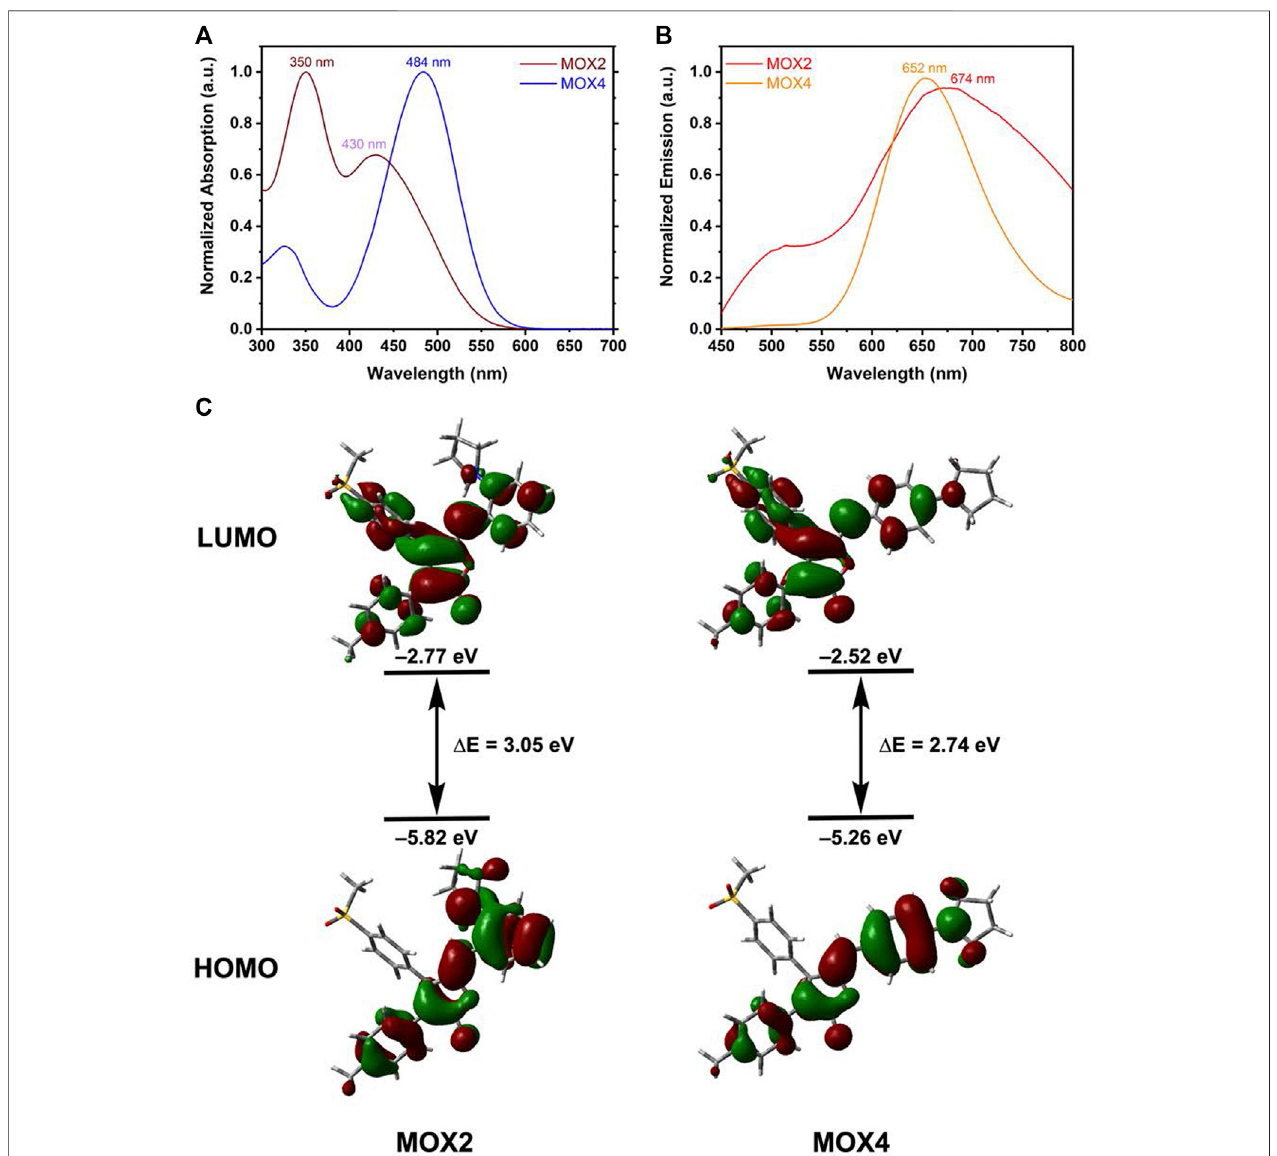
FIGURE 2 | Normalized absorption (A) and PL (B) spectra of MOX2 and MOX4 dyes in DMSO (50 μ M). (C) The optimized structure of MOX4 , MOX2 , and their HOMO and LUMO at the B3LYP/6-31++G (2 d, p) level.